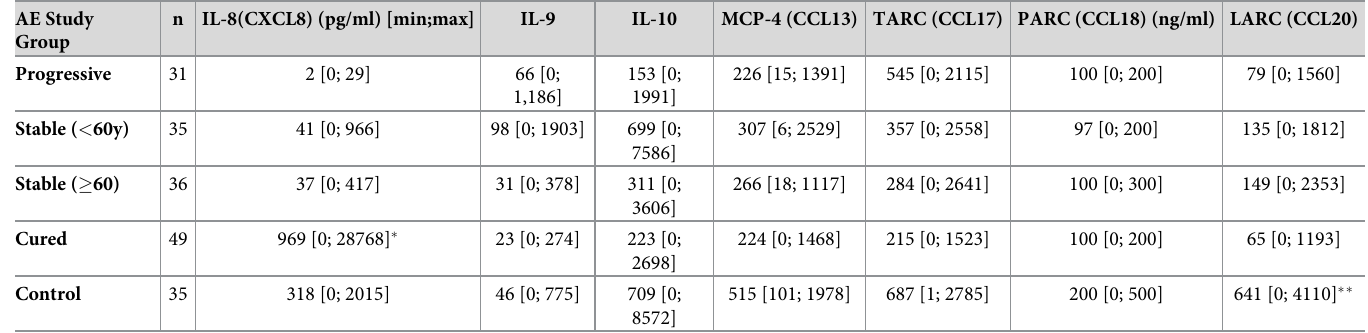
Table 8. Serum concentrations of cytokines and chemokines. Cytokines IL-8, IL-9 and IL-10 and chemokines MCP-4(CCL13), TARC(CCL17), PARC(CCL-18), LARC (CCL20) concentrations in pg/ml (mean [min, max]) were quantified by specific sandwich ELISA. The alveolar echinococcosis (AE) patients were staged in 4 groups with progressive, stable with equal or younger than 60 years ( � 60y), stable older than 60 years ( > 60), and patients with cured AE. Control individuals were E . multilocularis infection-free. For IL-8: � Tukey-Kramer Test: p = 0.04 Cured vs. Control and vs. Stable and vs. Vital/Progressive; For LARC(CCL20) �� Tukey-Kramer Test: p = 0.001 for Cured vs.